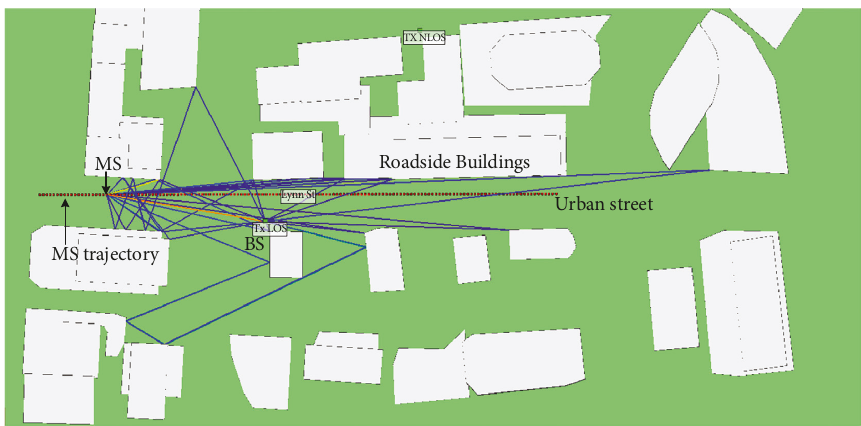
Figure 2: A bird view of the macro-cell urban street scenario.